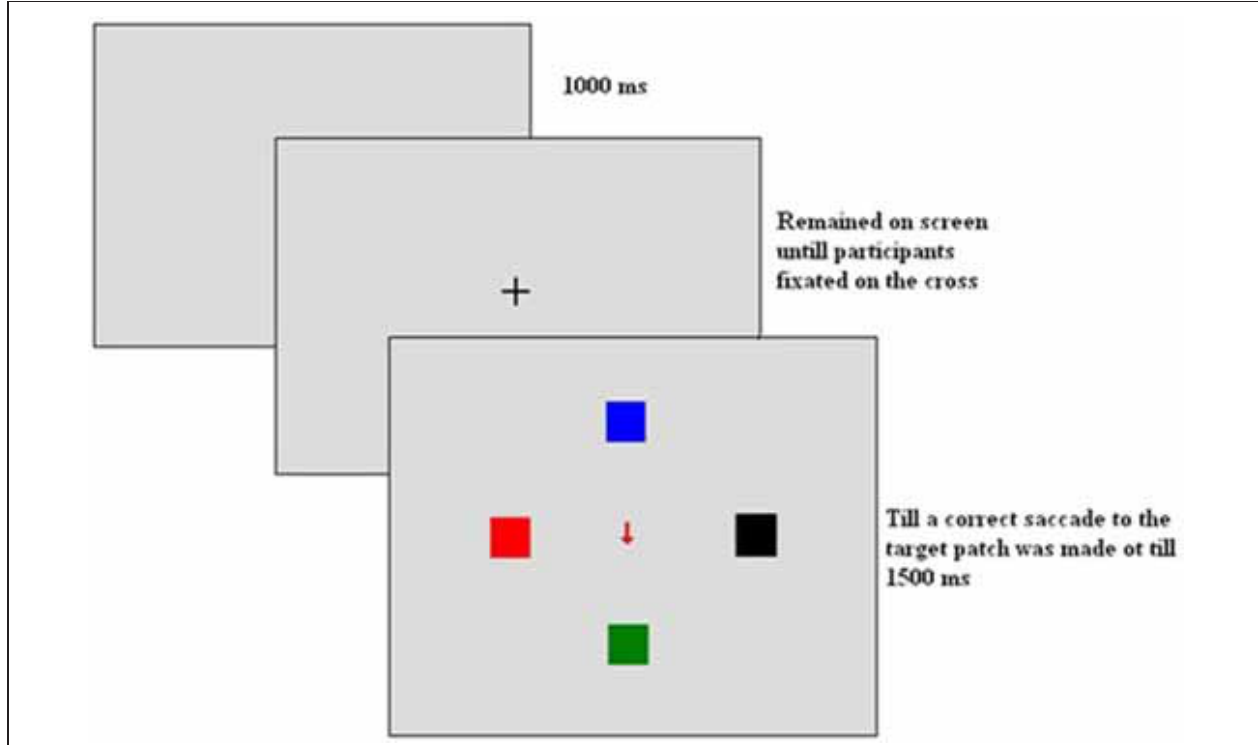
FIGURE 1 | A sample trial sequence for an incongruent